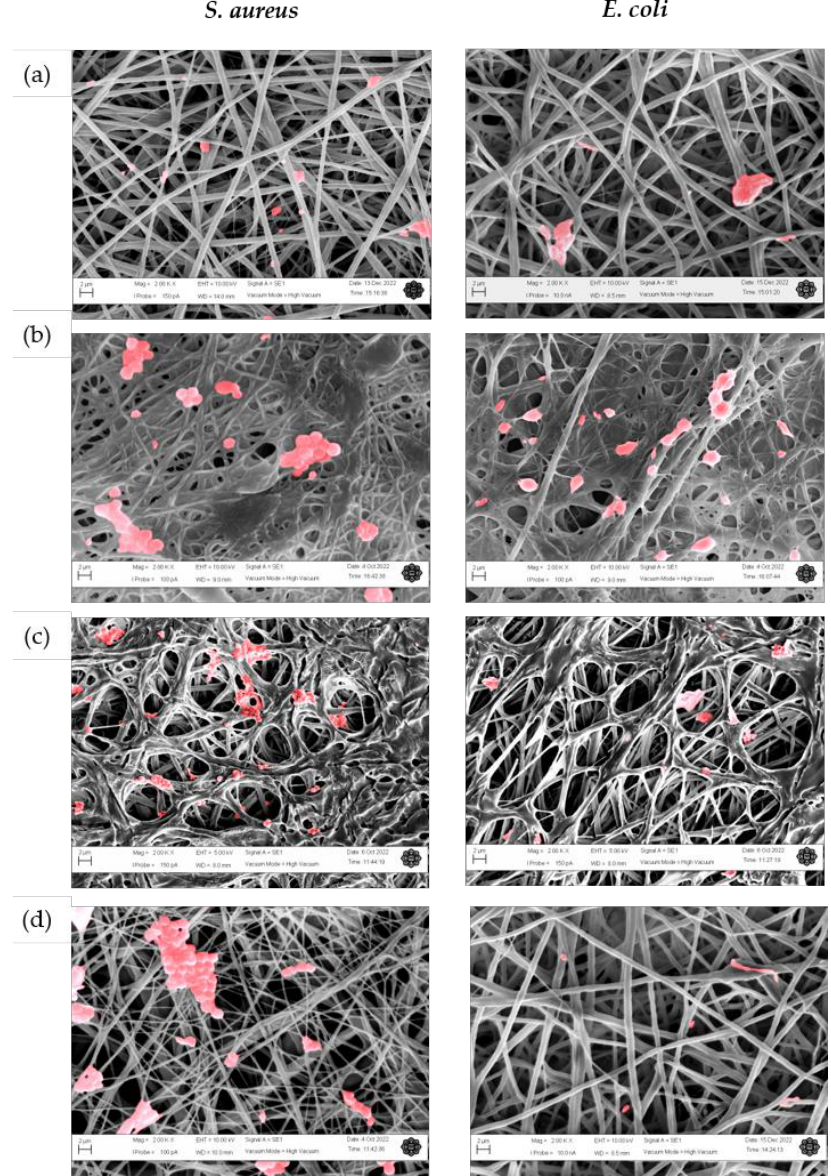
Figure 11. SEM images of bacteria attachment on ( a ) PGO; ( b ) PGO-M1; ( c ) PGO-M2; and ( d ) PGO-M3 nanofibers at 2000 magnification. Red indicates bacteria colonies (Scale bar: 2 µm).